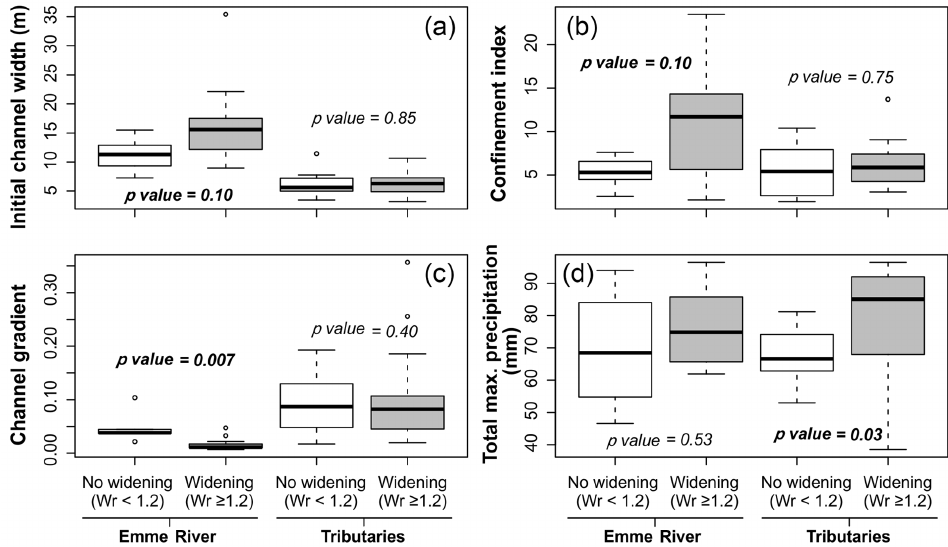
Figure 6. Box plots of morphological variables (initial channel width, confinement index, channel gradient) and total maximum precipitation for all sub-reaches showing widening (i.e., width ratio ≥ 1 . 2; grey boxes) and sub-reaches not showing widening (i.e., width ratio < 1 . 2). The bottom and top of the box indicate the first and third quartiles, respectively, the black line inside the box is the median, and circles are outliers. The Wilcoxon signed rank test result ( p value) for the significance of differences is also shown; bold indicates significant differences.